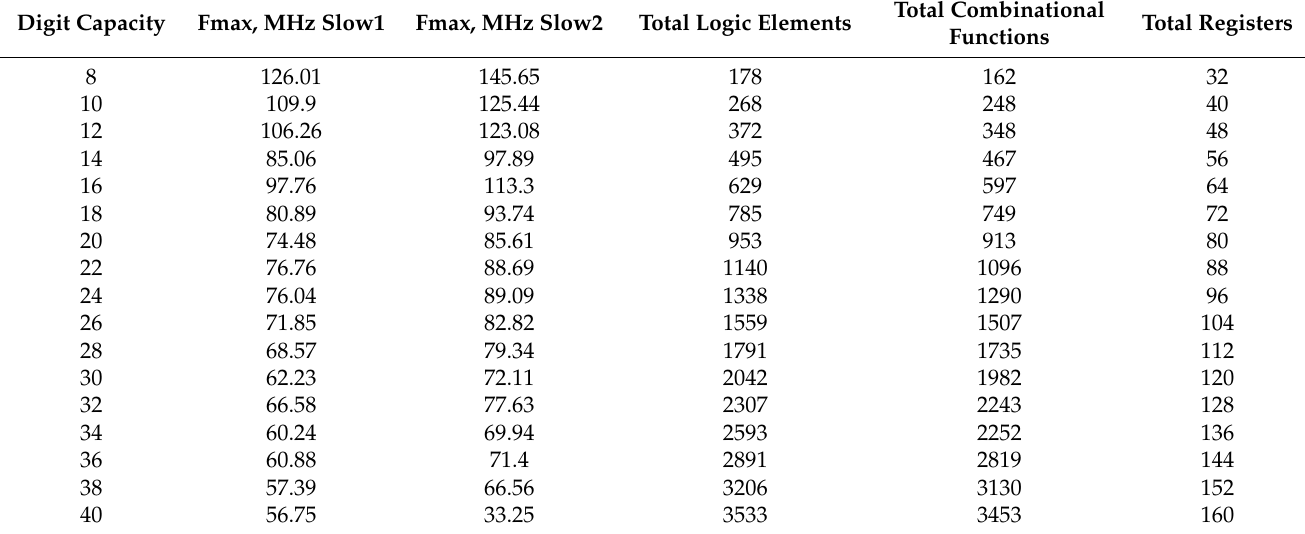
Table 4. Characteristics of modified Booth’s multiplier for multiplication of two binary codes.